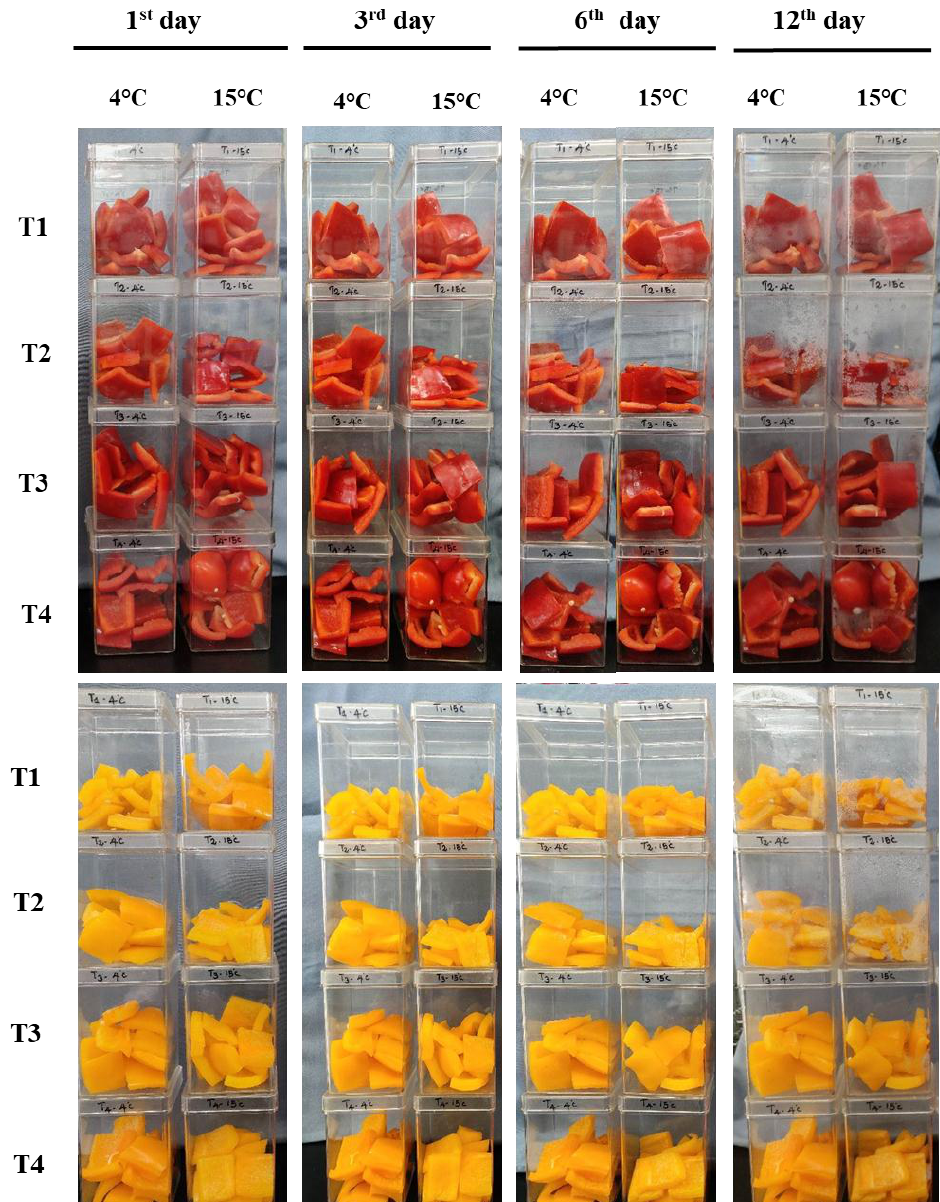
Figure 1. Effect of the Lactobacillus rhamnosus GG and biochemical additive treatments on visual appearance and sensory properties of red (R) and yellow (Y) fresh cut bell pepper (FCBP) in relation to day 1, day 4, day 6, and day 12 intervals.